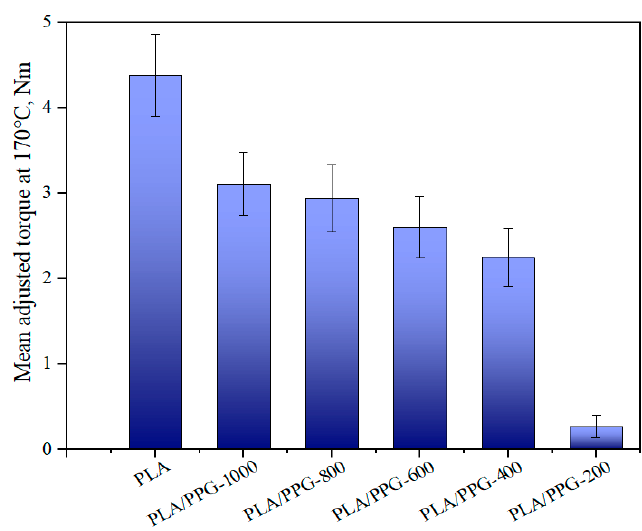
Figure 7. Mean value of the adjusted torque in the interval from 15 to 20 minutes for the neat PLA and PLA / PPG composites. Table 2. Terminal process parameters for the neat PLA and PLA / PPG composites (15–20